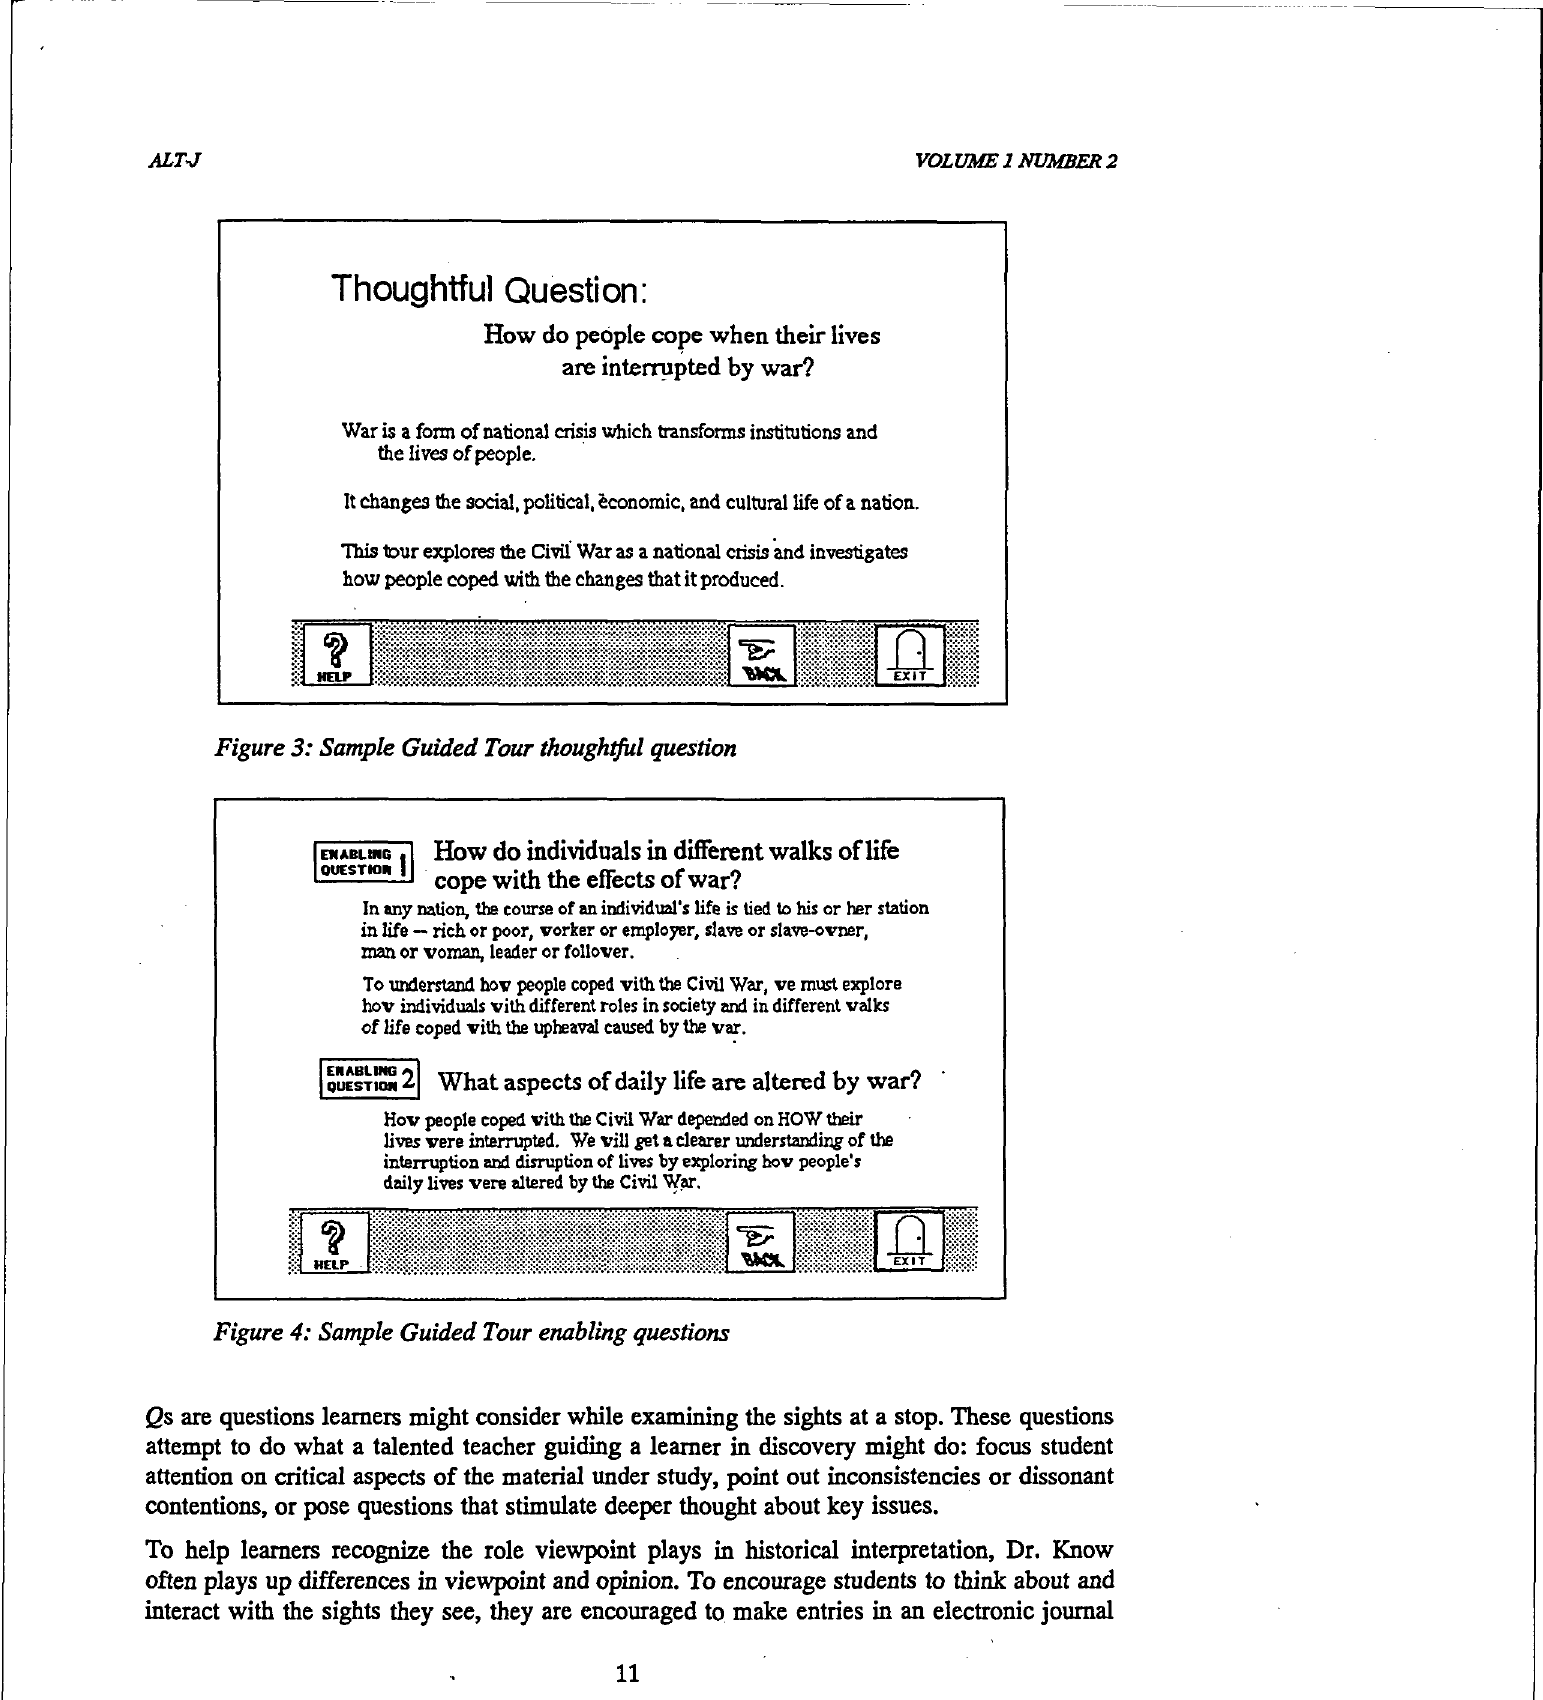
Figure 4: Sample Guided Tour enabling